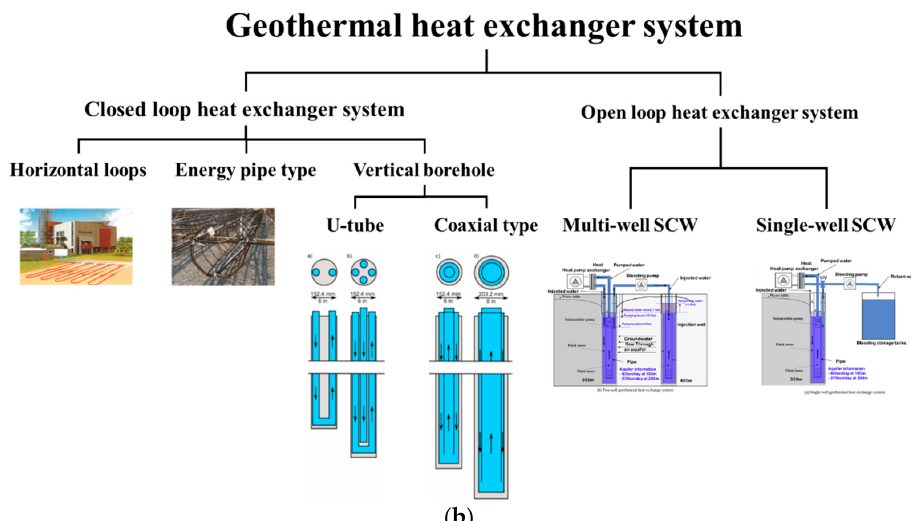
Figure 1. Schematic diagram of ground-source heat pump geothermal heat exchange systems: ( a ) installed examples; ( b ) classification of geothermal heat exchanger system.